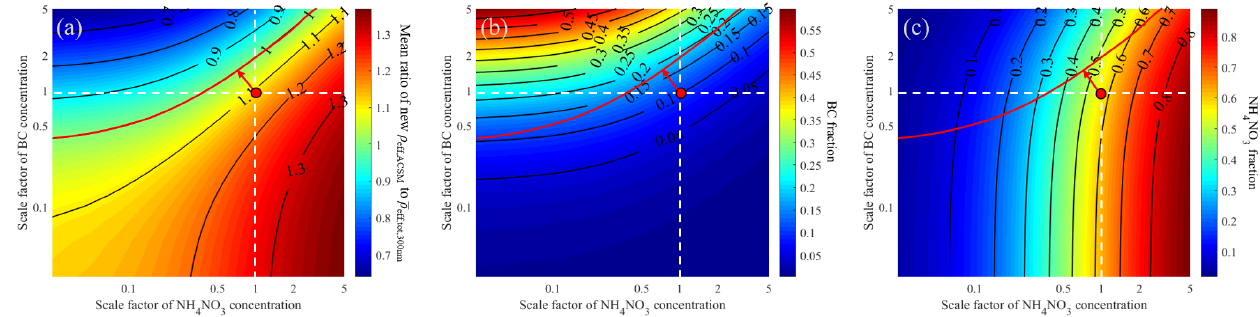
Figure 11. (a) Mean ratio of new calculated ρ eff , ACSM versus measured ρ eff , tot , 300nm based on a scale factor of NH 4 NO 3 and BC mass concentrations ranging from 0.01 to 5 (at logarithmic scale), (b) the corresponding BC mass fraction, and (c) the corresponding NH 4 NO 3 mass fraction under the more polluted conditions. The black lines represent contours with the same values. The vertical and horizonal dotted white lines represent NH 4 NO 3 and BC mass concentration at the scale factor of 1, respectively, and the red circles are the original mass concentrations of BC and NH 4 NO 3